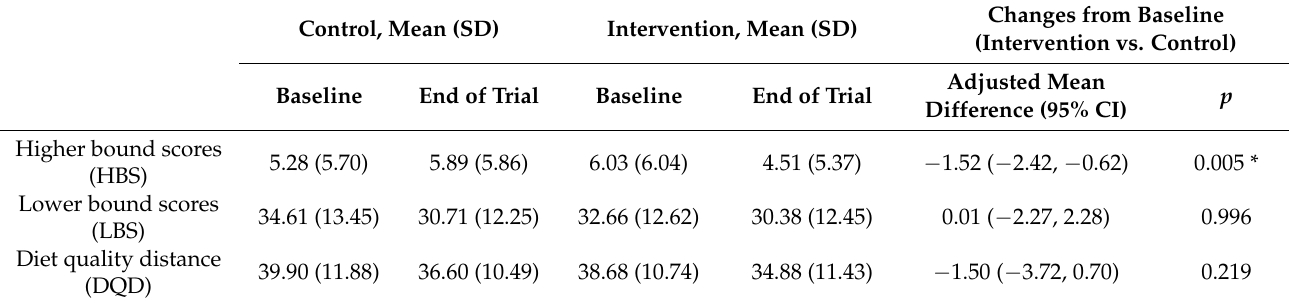
Table 3. Effects of intervention on three dietary quality indicators a .